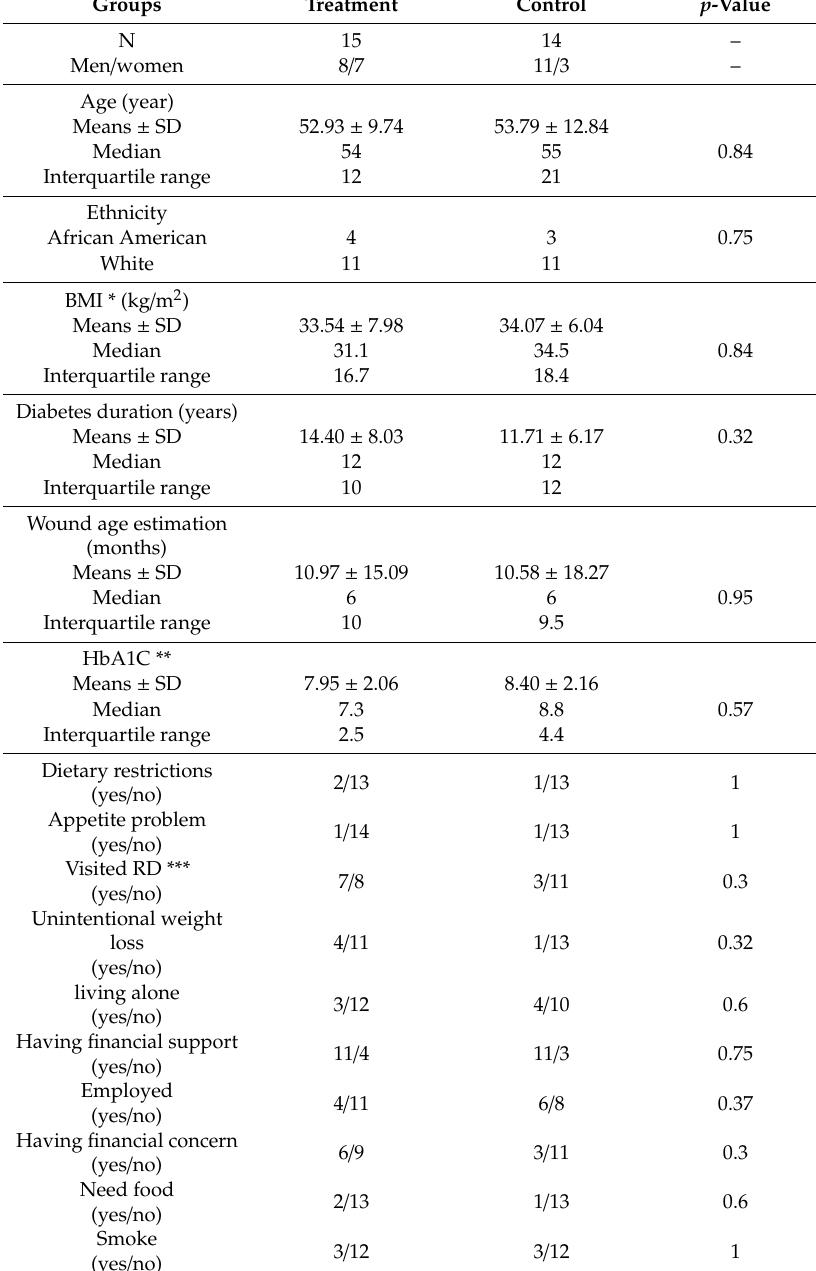
Table 2. Baseline characteristics of participants by